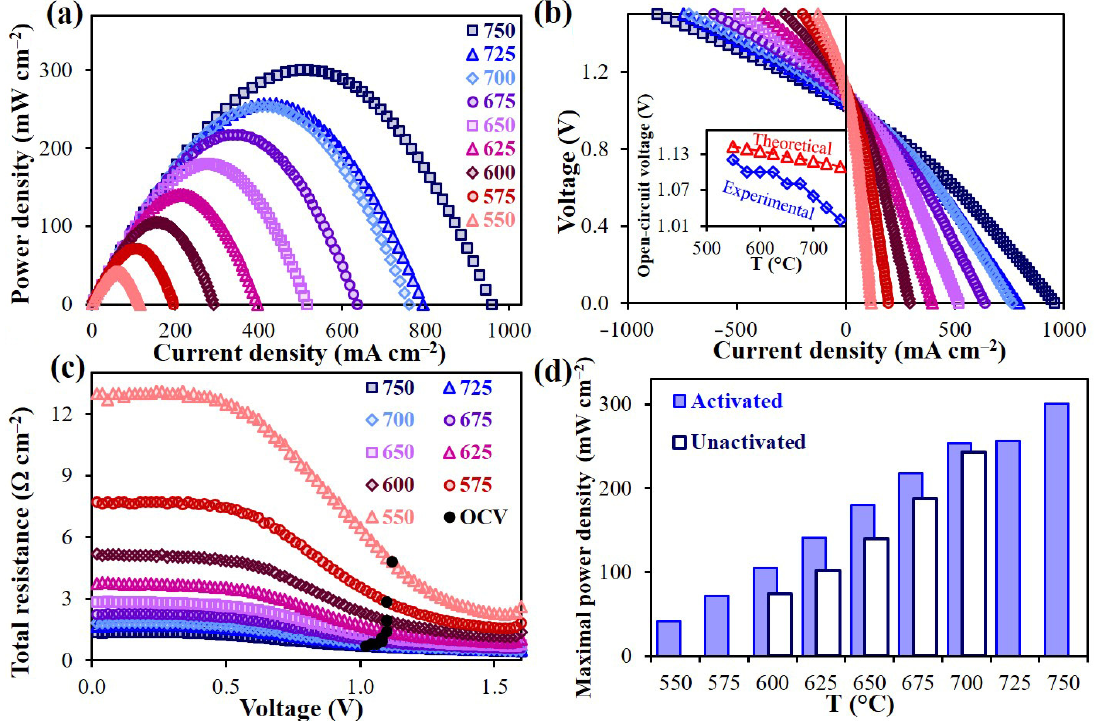
Figure 11. Power density dependencies of the electrochemical cell with BCZYF0.6 cathode ( a ), voltammetric characteristics ( b ), total resistances ( c ), and comparison of the maximum cell power densities before and after electroactivation ( d